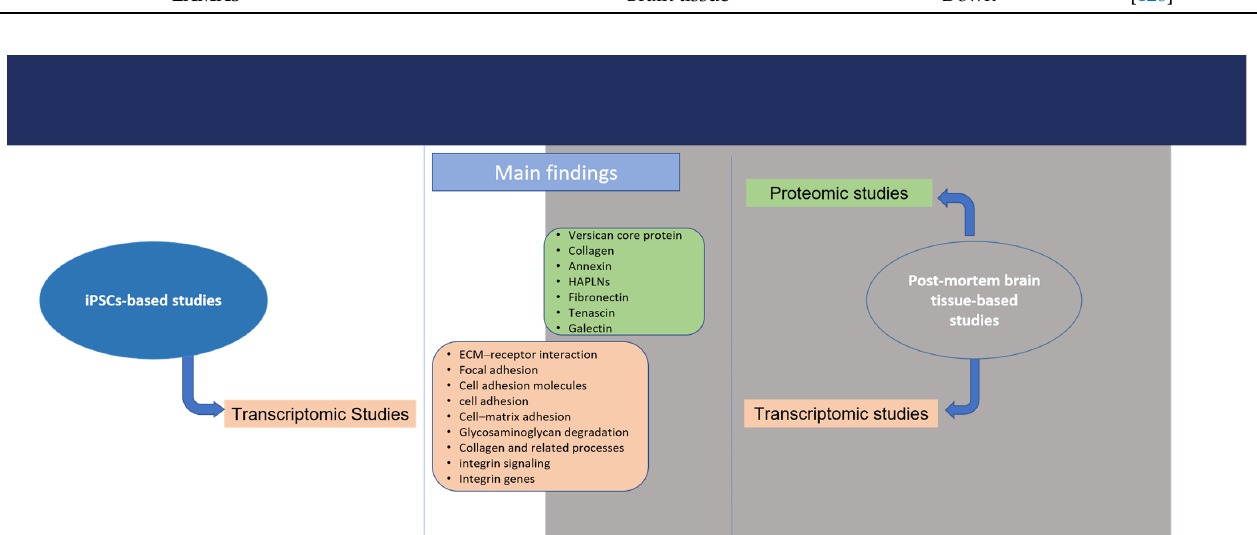
Figure 7. A diagram showing the main fi ndings from all studies included in the review (the color of the study type is matched with the listed main fi nding; the gray background is for postmortem brain tissue-based studies and the white background is for iPSC-based studies, orange color for transcriptomic studies with related fi ndings and light green for proteomic studies with related fi ndings).